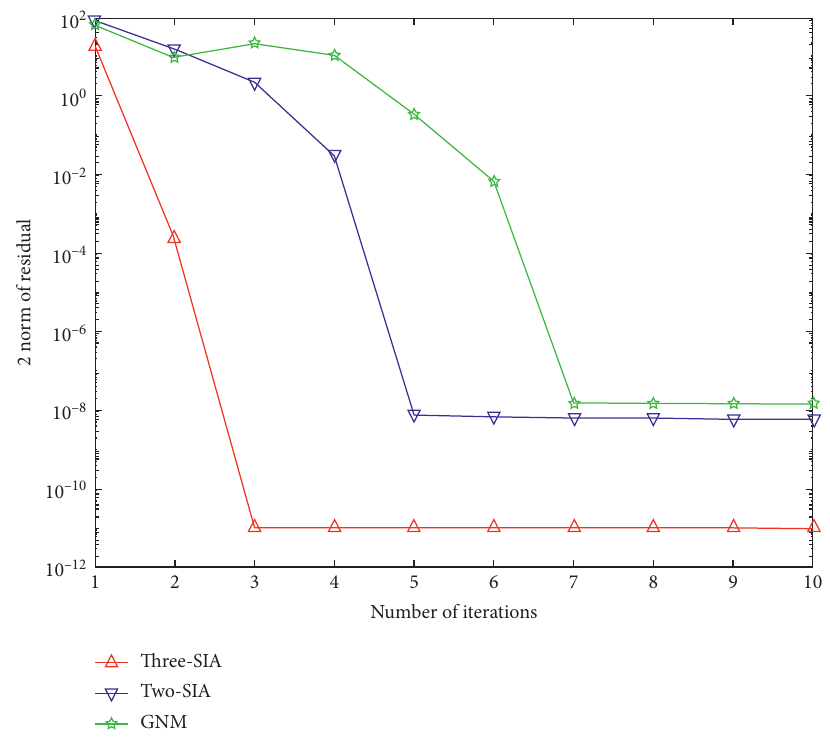
Figure 1: The convergence curve of three-SIA, two-SIA, and GNM for Example